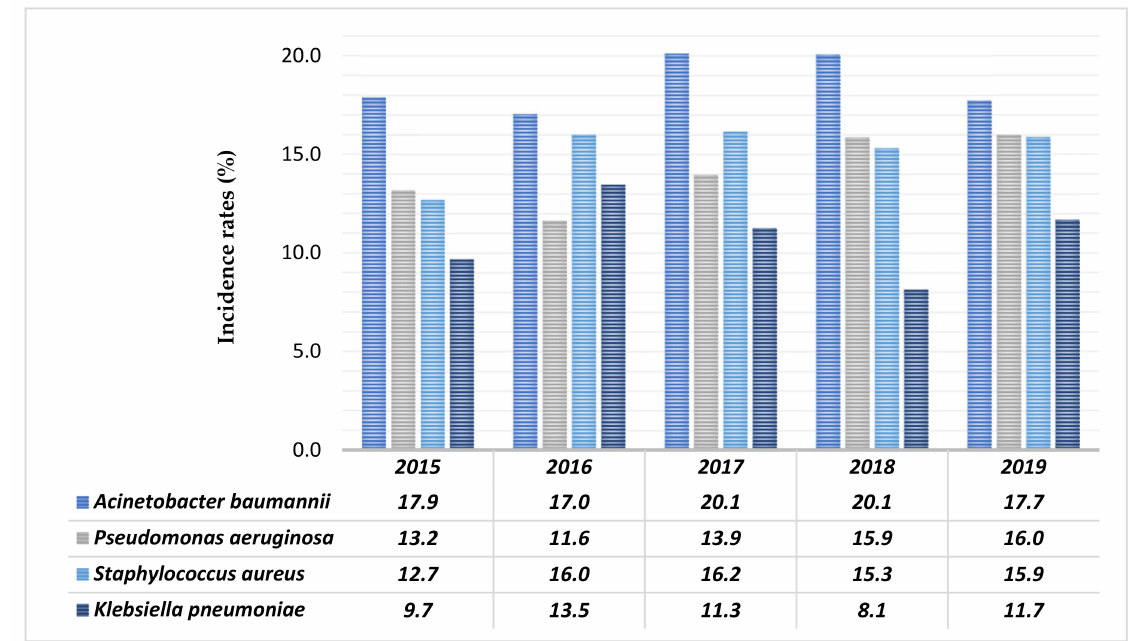
Figure 2. Annual incidence rates of the main bacteria isolated from positive samples.